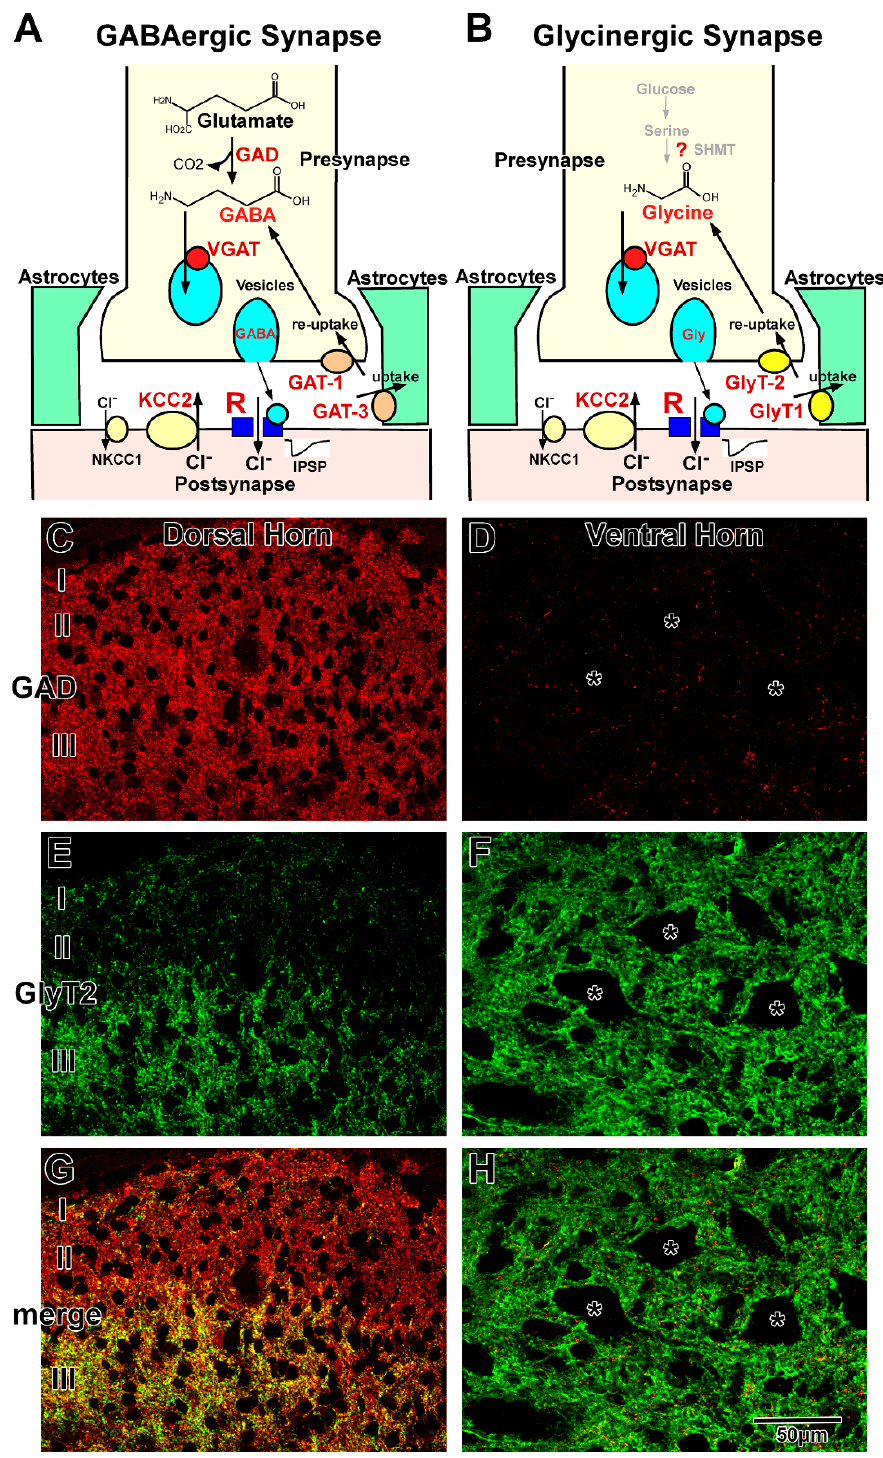
Figure 1. GABAergic and glycinergic transmission in the adult spinal cord. ( A , B ) are Schematic illustrations of GABAergic ( A ) and glycinergic ( B ) synapses. Various key molecules are involved in GABAergic and glycinergic transmission. C and D are Immunohistochemistry for GAD ( C , D ), GlyT2 ( E , F ), and both ( G , H ) in the dorsal ( C , E , G ) and ventral ( D , F , H ) horns. In lamina I and II, GABAergic terminals are dominant ( C ), whereas GAD and GlyT2 double-positive colocalizing terminals (yellow) are dominant in lamina III of the dorsal horn ( G ). In the ventral horn, glycinergic GlyT2-positive terminals (green) are dominant ( F ), but GABAergic GAD-positive terminals (red) are scarce ( F , H